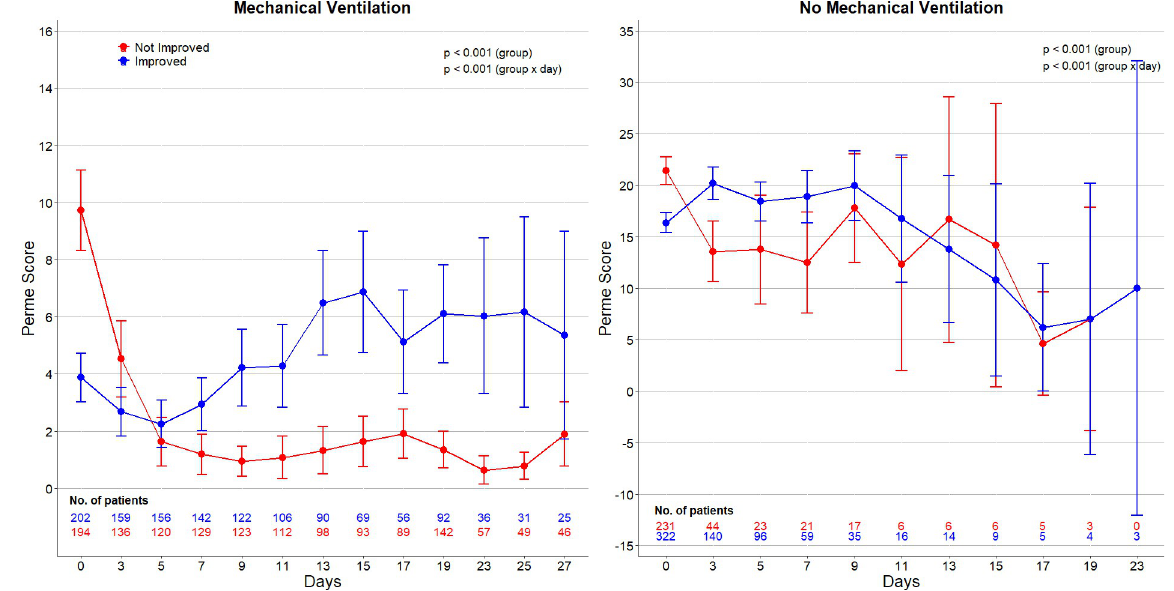
Fig 1. Perme score over the first 27 days of ICU admission. Circles are mean and error bars are 95% confidence interval. P value from a mixed-effect generalized linear model with Gaussian distribution, with group and time, and a group x time interaction as fixed effect, and the patients as random effect to account for repeated measurements. The number of patients with available data decreases over successive study days due to deaths and discharges. � Perme ICU mobility score ranges from 0 to 32, with higher scores indicating better mobility level.